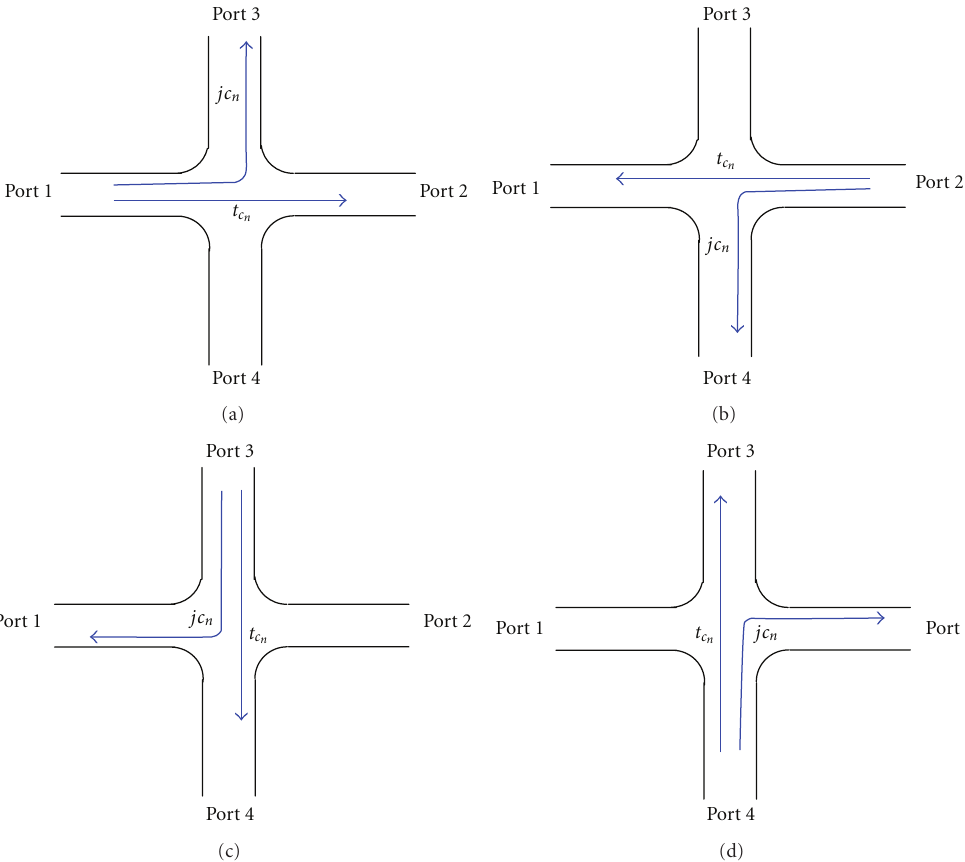
Figure 4: A four-port coupler showing the transmission ( t c n ) and the coupling ( jc n ) coe ffi